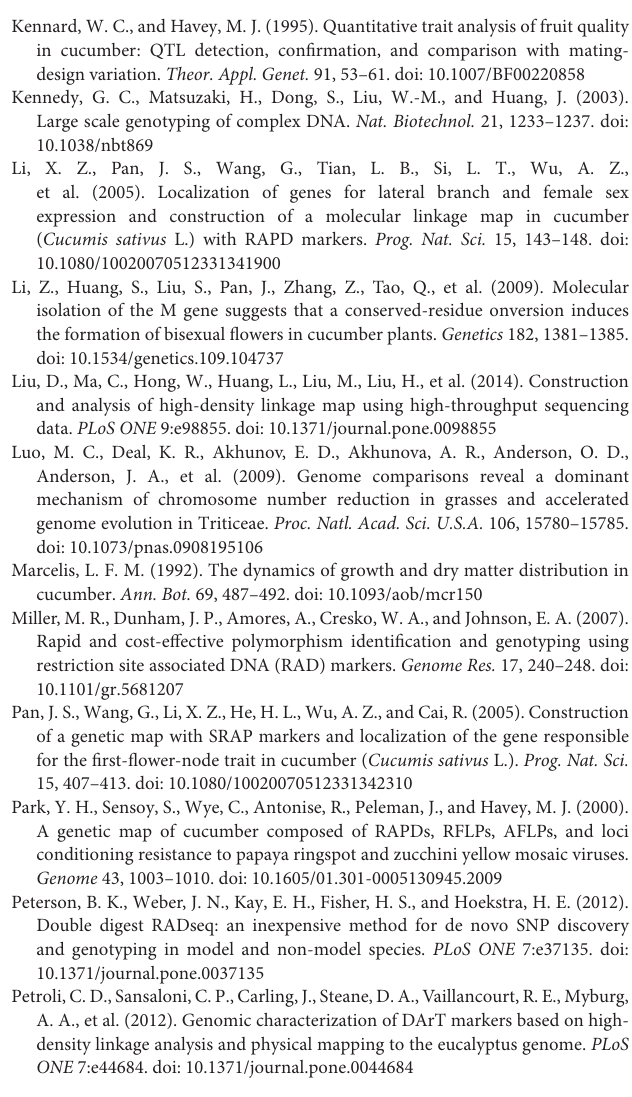
TABLE S1: | Sequence information of total SLAFs. TABLE S2: | Sequence information of mapped SNPs. TABLE S3: | Physical position of mapped